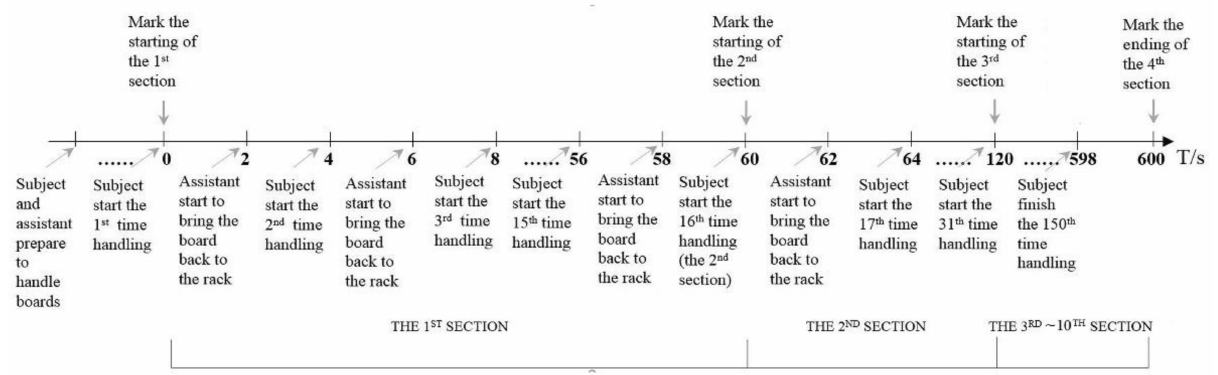
Figure 4. Illustration of the repetitive material handling